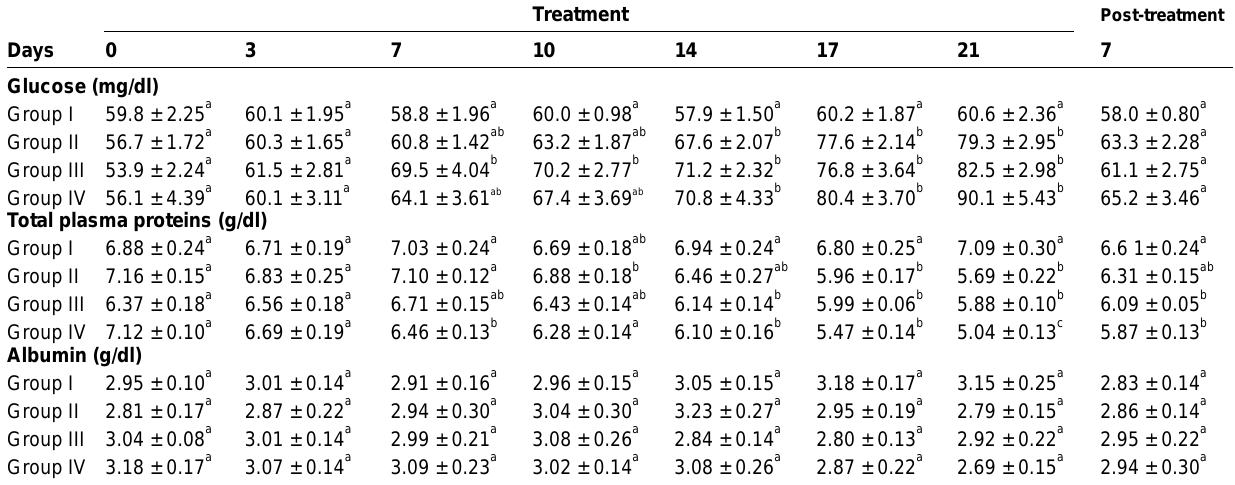
Table-3. Effect of sub-acute oral administration of fenvalerate (1 mg/kg/day) and sodium nitrate (20 mg/kg/day) combination on plasma cholesterol, blood urea nitrogen and creatinine in buffalo calves. Treatment